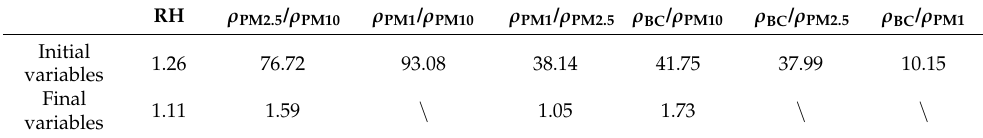
Table 2. VIF values of explanatory variables.